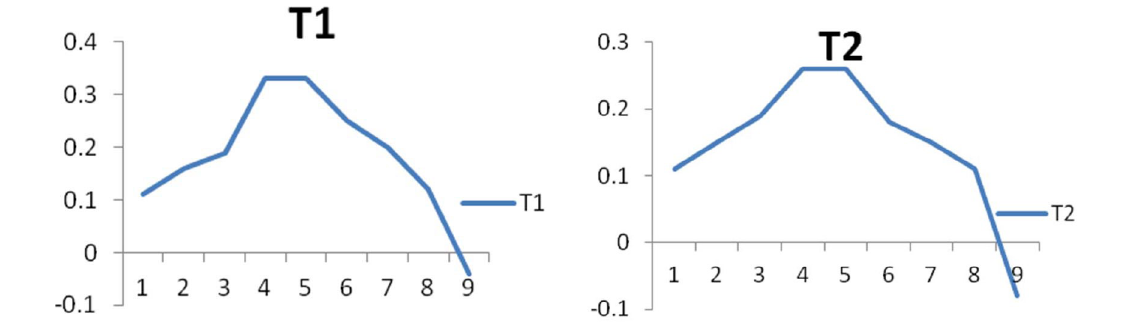
Fig. 1. Graph represents the growth curve of organism T1 Fig. 2. Graph represents the growth curve of organism